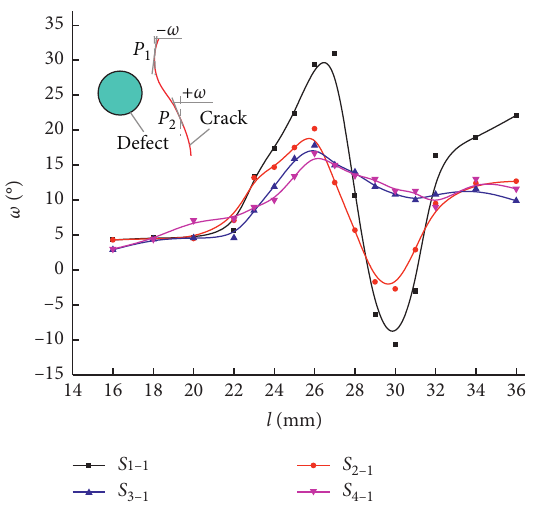
1-1 , (b) S 2-1 , (c) S 3-1 , and (d) S 4-1 .